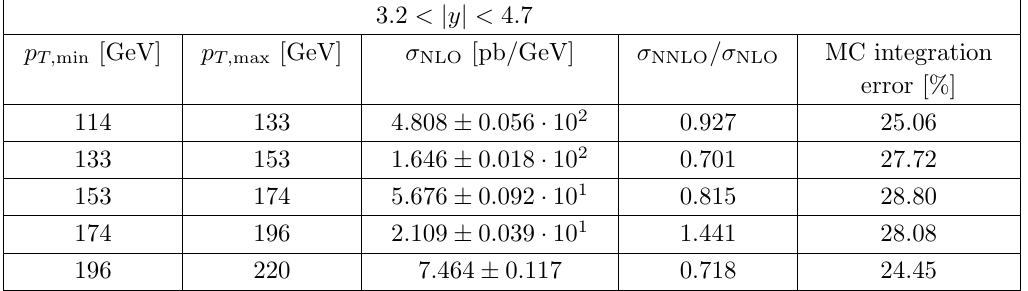
Table 7 . NLO QCD single-inclusive cross section and NNLO QCD K-factors in the rapidity slice y < 4 : 3 : 2 < j j